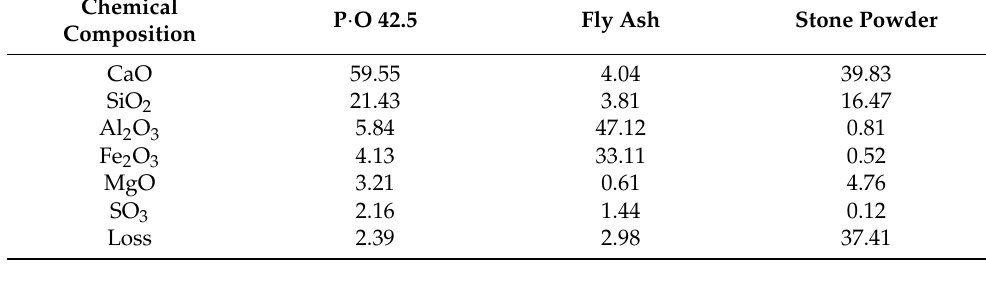
Table 2. Chemical compositions of raw materials (%).